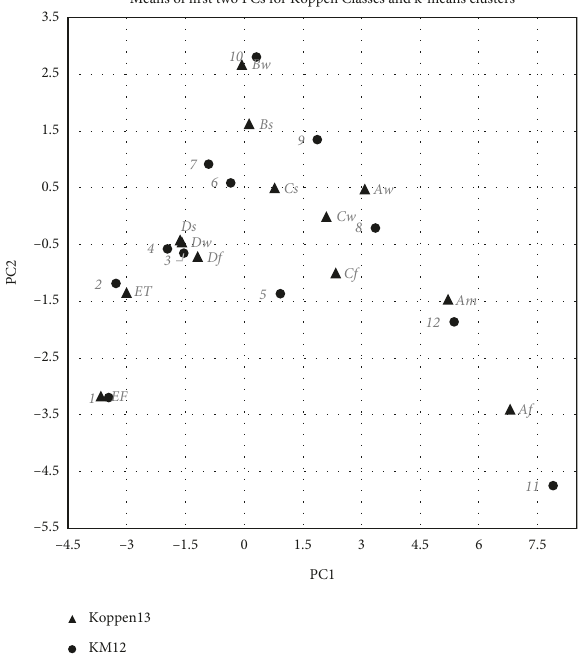
Figure 12: Means of the two PCs for the 13 level-2 KG climates (K¨oppen13) and 12 k -means clusters (KM12). Centers of some clusters (5, 7, and 11) are distant from any KG class